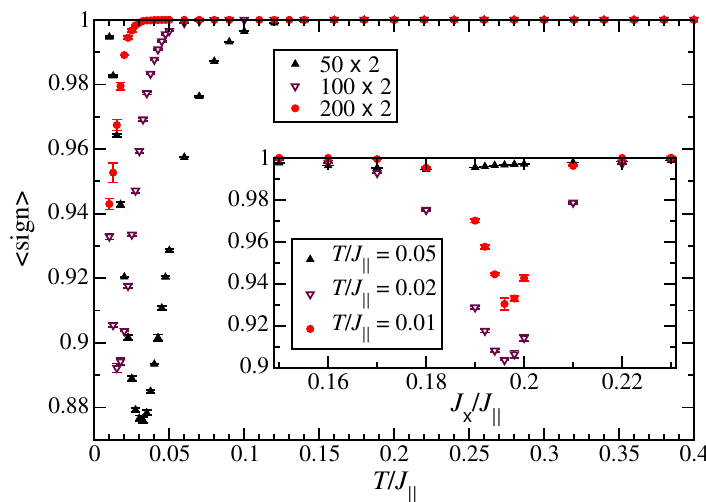
Figure 4: Average sign, 〈 sign 〉 , for a QMC simulation in the rung basis using the parameters J ⊥ = 0.38, J (cid:107) = 1, and J × = 0.196, shown as a function of temperature for ladders with L = 50, 100, and 200 rungs. The thermodynamic response of this system is shown in Fig. 12. Inset: 〈 sign 〉 shown as a function of J × for a ladder with J (cid:107) = 1, J ⊥ = 0.38, and L = 100 rungs, at three temperatures, T / J (cid:107) = 0.01, 0.02, and